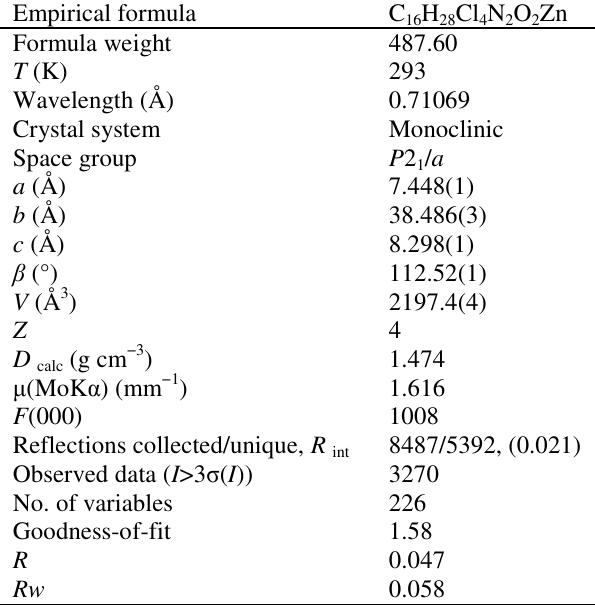
Table 1 . Crystal and experimental